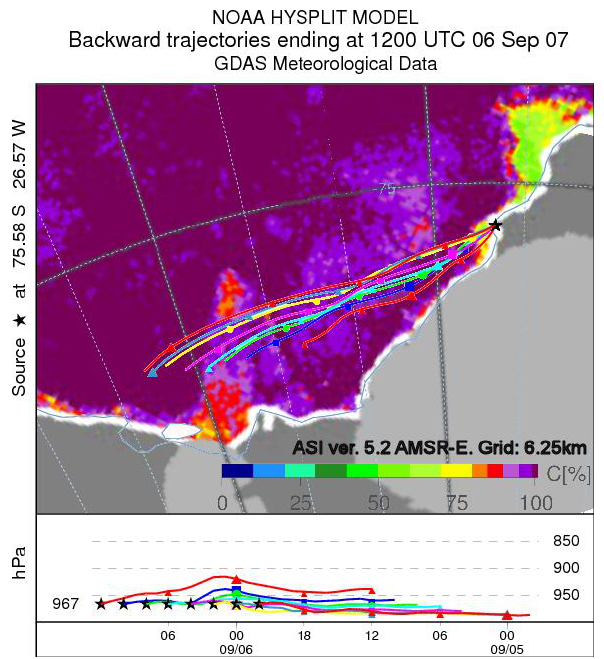
Fig. 2. 2-day back trajectories showing air parcel history (location and atmospheric pressure) prior to arrival at Halley on 6 Septem- ber 2007 overlaid on an AMSR-E image of percentage sea-ice cover. The star marks the position of Halley, and the symbols mark 6-hourly